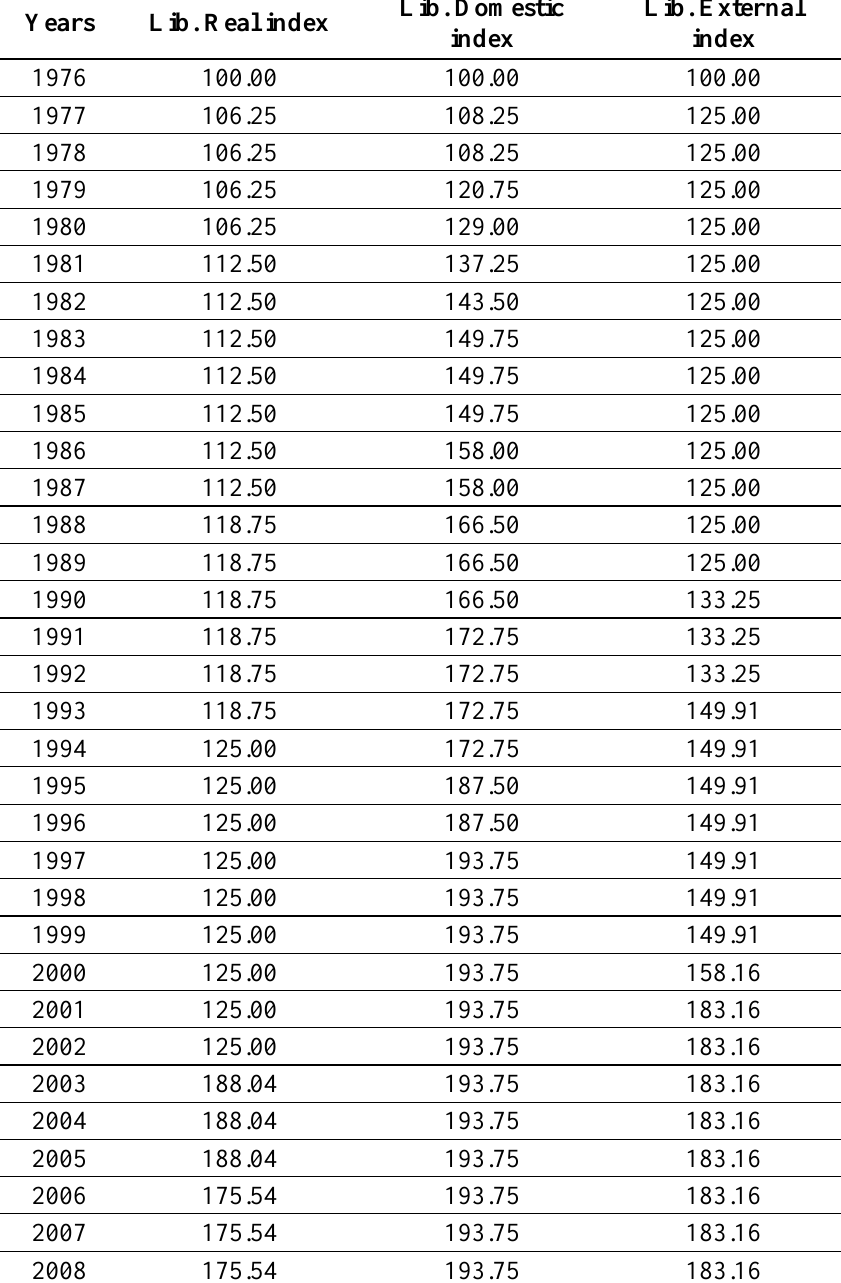
Table 01: Liberalization Indices - Final